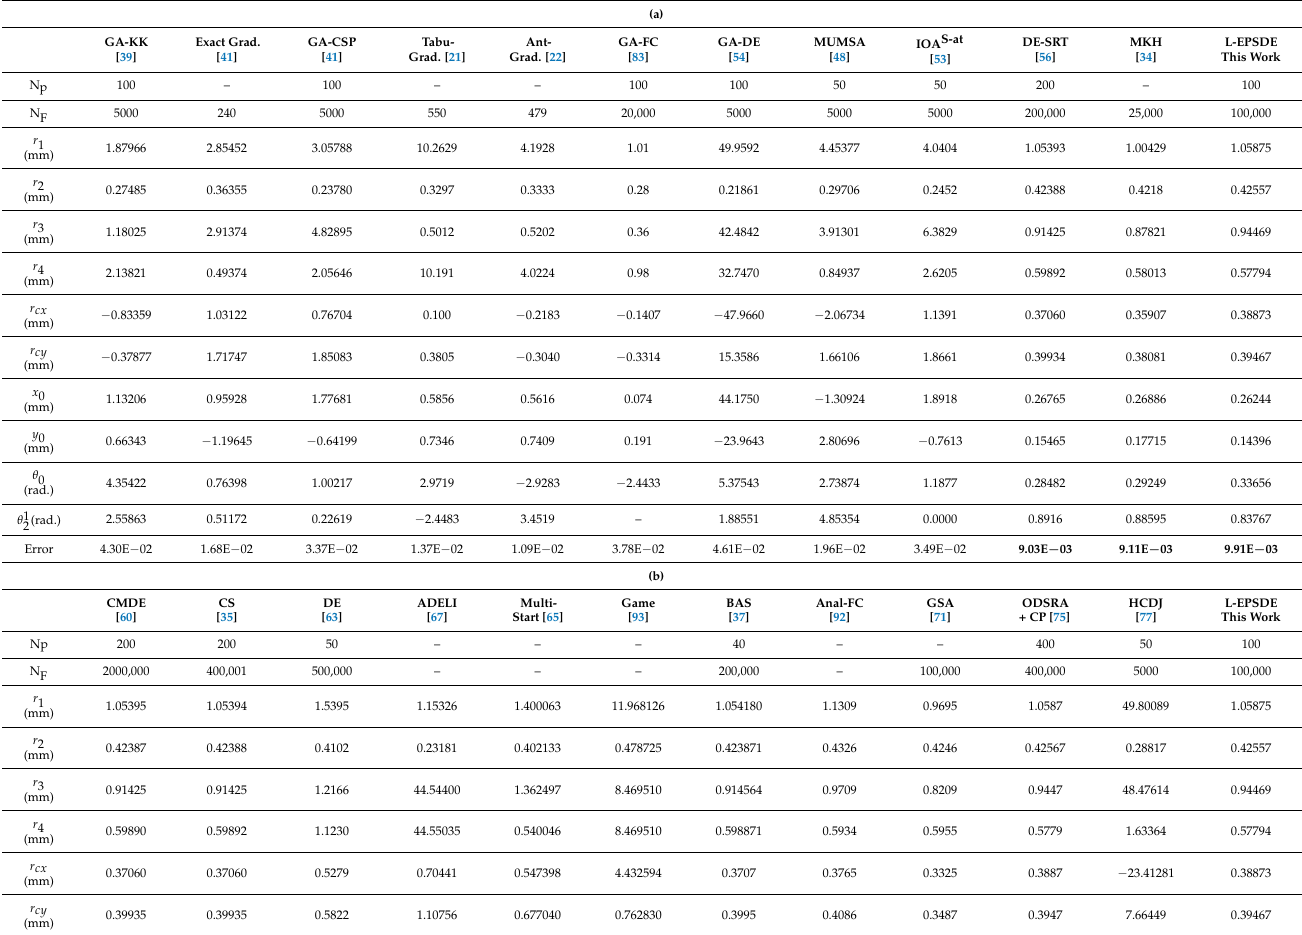
Case 3: Semi-circular arc curve ( 6 target points, 9 design variables).